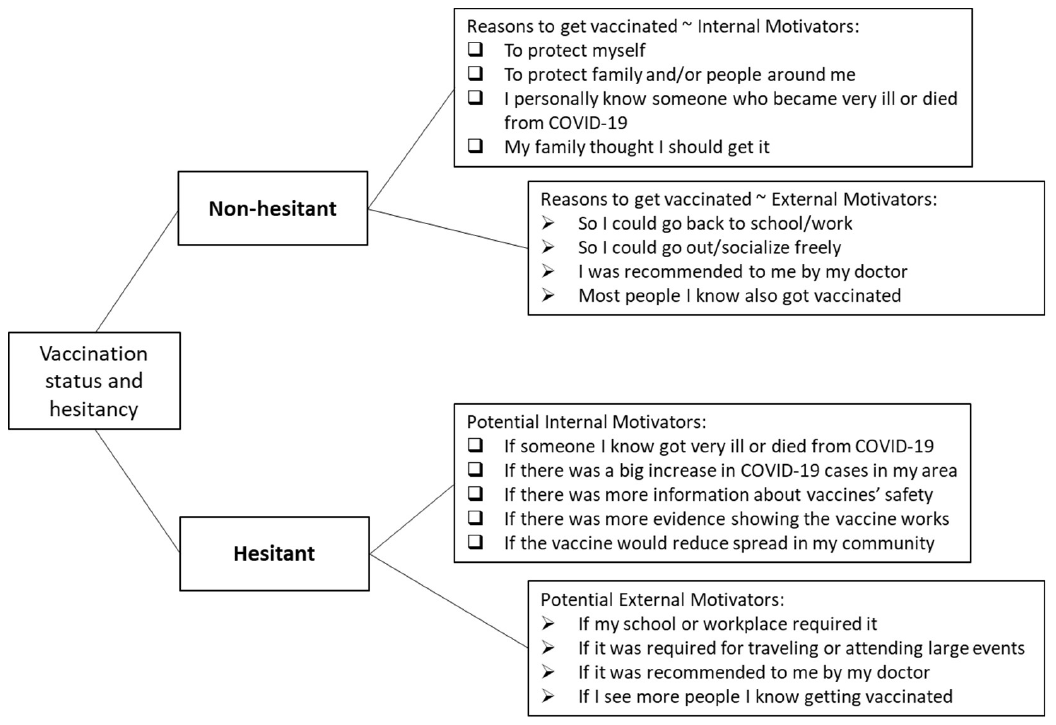
Figure 1. Survey query flow and motivation question items categorization.